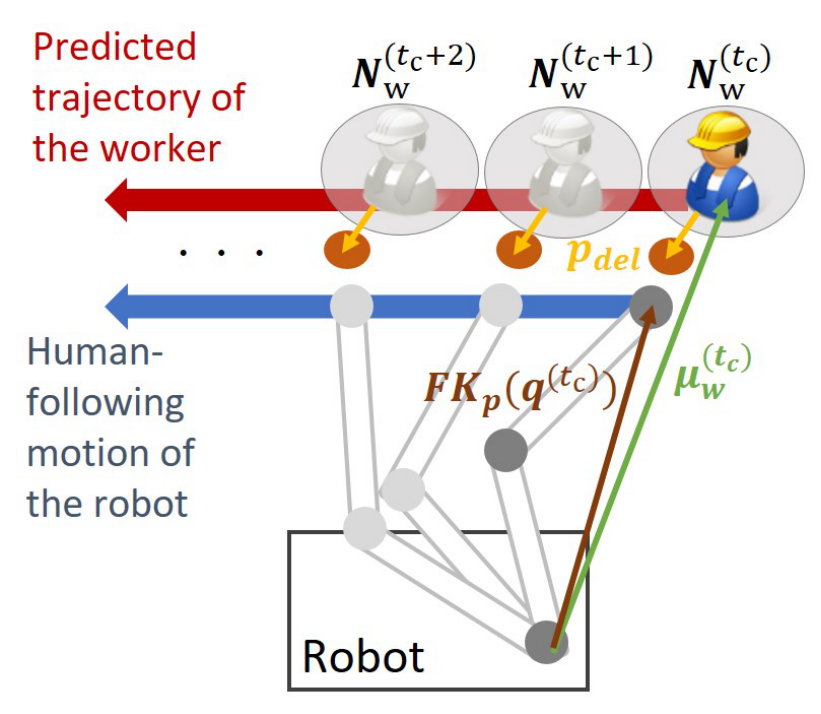
Figure 3. Concept of human-following motion planning based on the predicted trajectory of the